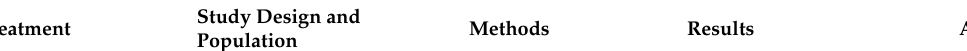
Table 3. Clinical